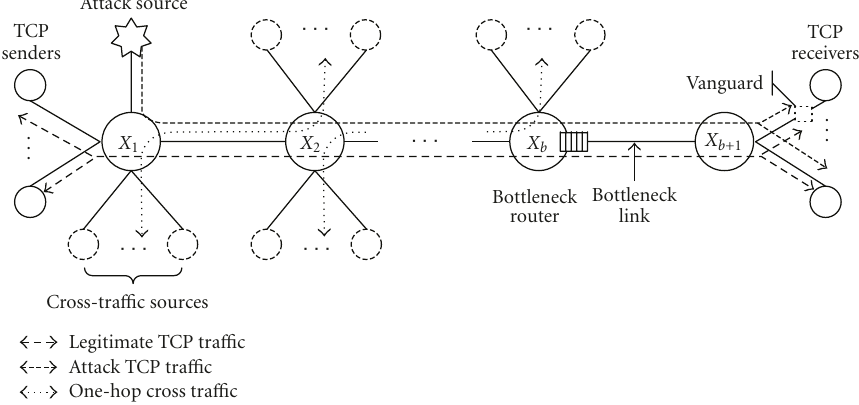
Figure 3: A general testbed for the empirical evaluation of Vanguard and other detection